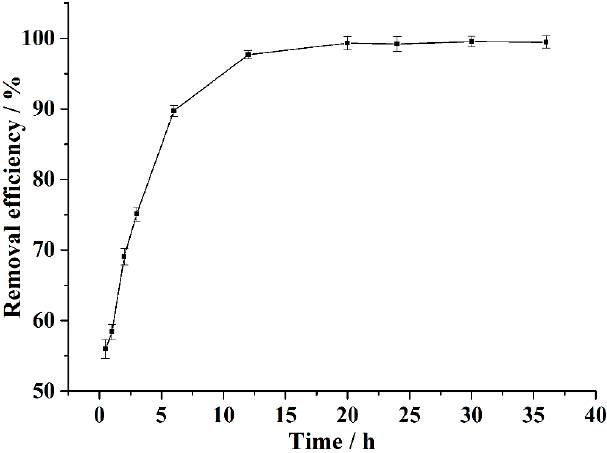
Figure 5. Effect of the contact time on the removal efficiency of Alg–PAM for Pb 2+ .